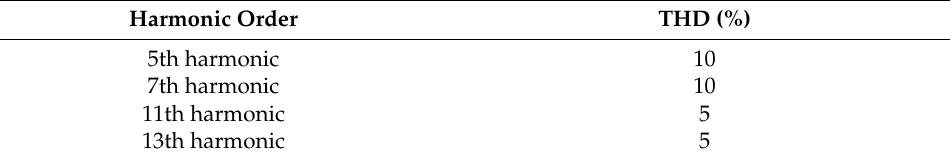
Table 1. Harmonic composition of scenario 2.